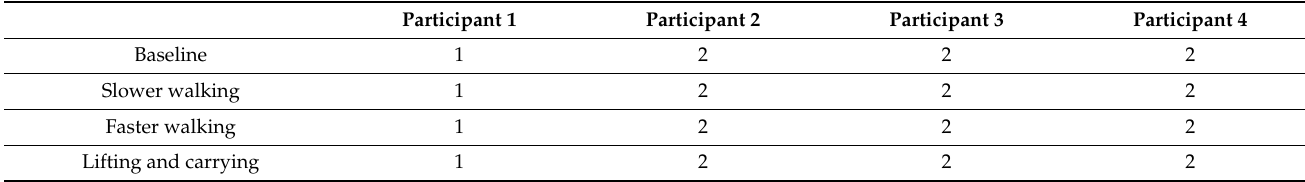
Table 6. Thermal Acceptability results for each participant for the Loose Leg Sleeve, where − 1 represents unacceptable, 0 just unacceptable, 1 just acceptable, and 2